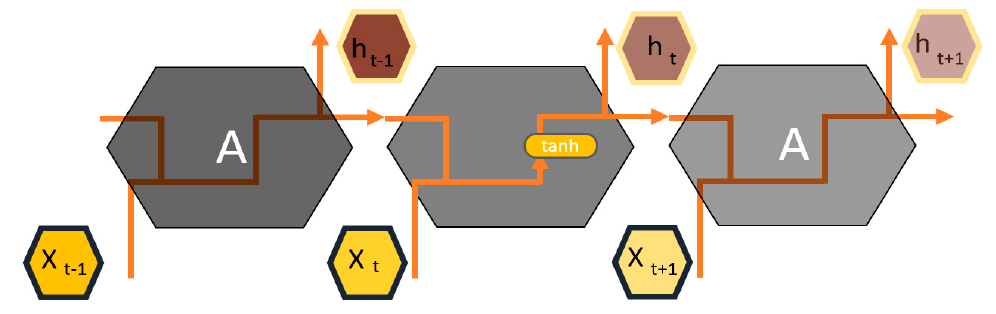
Figure 3. Schematic of a repeating module in RNN [40].